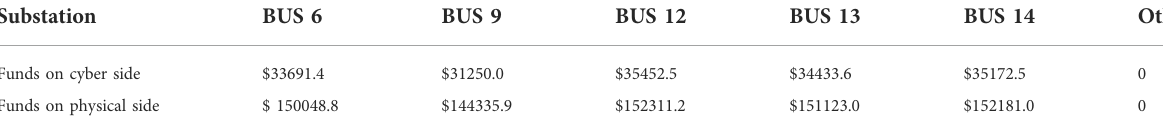
TABLE 11 Overall expectations of the fund deployment of attacker and defender.